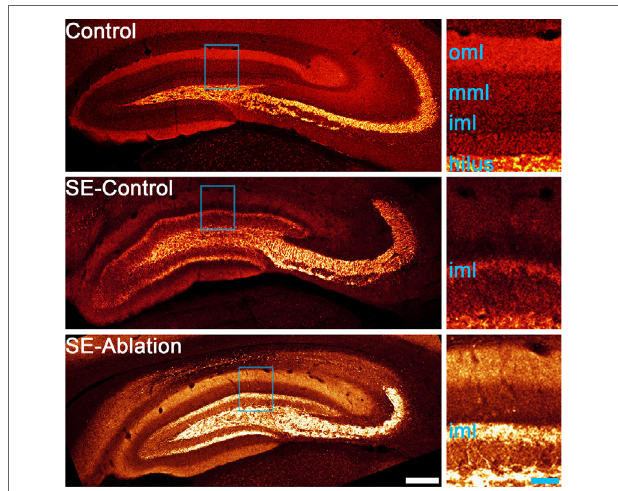
FiGURe 1 | Confocal maximum projections showing mossy fiber axons labeled with zinc transporter-3 (red). A control animal and two epileptic animals are shown. Tissue from epileptic animals was collected about 5 months after pilocarpine-induced status epilepticus (SE). The epileptic animal shown in the middle panel received a control ablation treatment (SE-control), while newborn granule cells were ablated from the epileptic animal in the lower panel 1 month before tissue collection (SE-ablation). Regions highlighted in blue in each image are shown enlarged in the right panels. Both SE animals show mossy fiber sprouting in the inner molecular layer (iml), while the control animal did not. Newborn granule cell ablation reduced seizure frequency by about 50%, but had no effect on mossy fiber sprouting (61). Abbreviations: oml, outer molecular layer; mml, middle molecular layer. Scale bars = 200 µm (left) and 50 µm